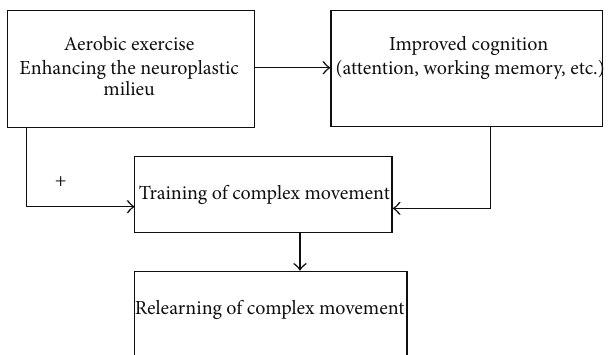
Figure 5: Proposed model of how aerobic exercise affects stroke outcomes. Aerobic exercise, by enhancing the neuroplastic milieu (increased neurotrophins, synaptogenesis, and dendritic branching and reducing oxidative stress), may improve cognition. AE, when combined with skilled task training, may potentiate relearning and recovery in two ways, (1) indirectly by improving attention and working memory to enhance relearning or (2) directly by enhancing activity-induced